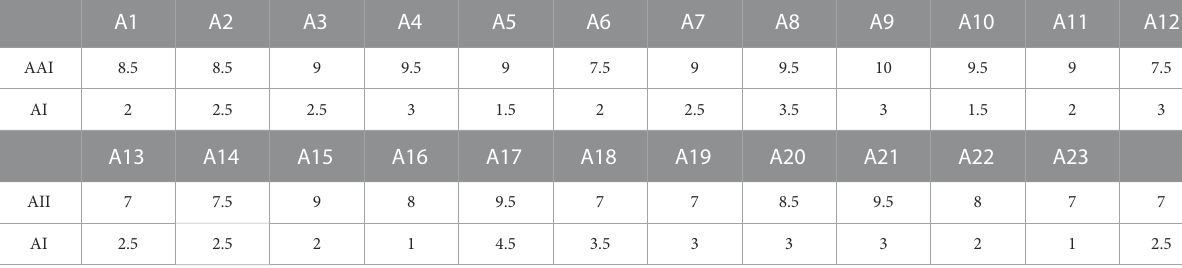
TABLE 6 The amount of AAI and AI for each criterion (Source: Author).